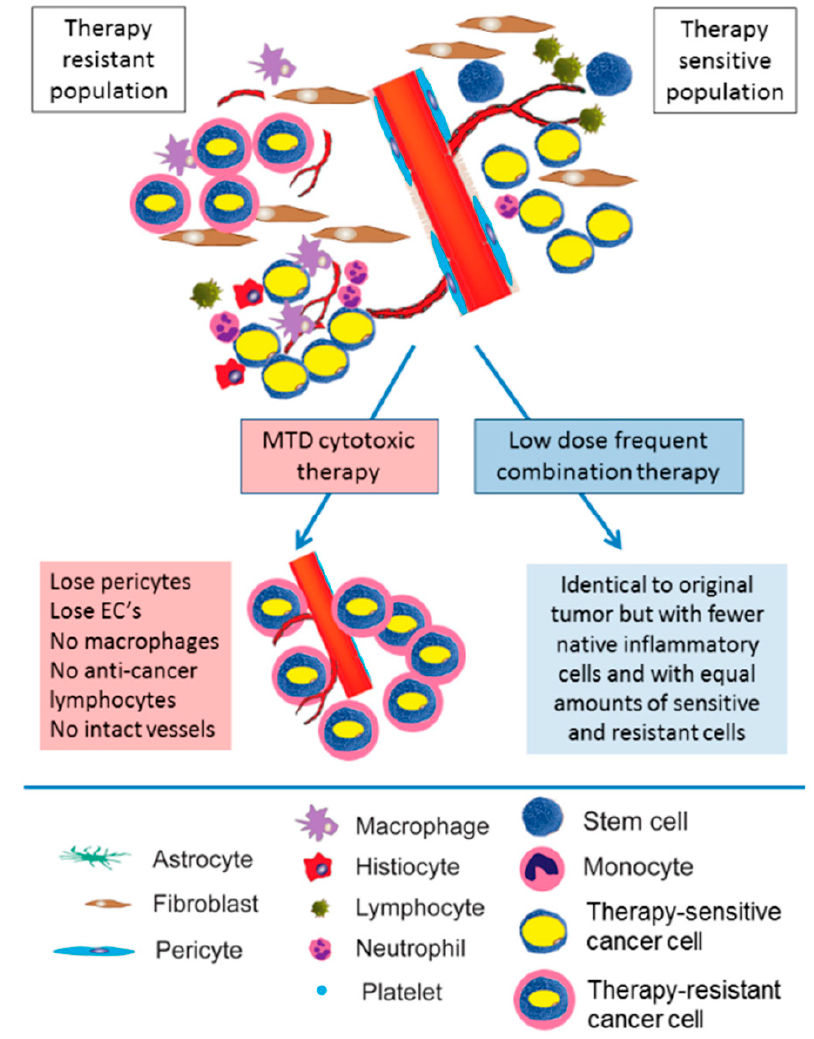
Figure 2. Comparison of the effects of maximally tolerated dose (MTD) and metronomic chemother- apy (MCT). MTD cytotoxic chemotherapy results in the ablation of anti-tumor immunity and the elimination of therapy-sensitive clones. In turn, these result in the selection of therapy-resistant cancer cells. In contrast, low-dose high-frequency (metronomic) chemotherapy targets the tumor stroma, gradually reducing tumor size but mostly maintaining tumor composition, decreasing therapeutic resistance, and maintaining anti-tumor immunity. Figures adapted from